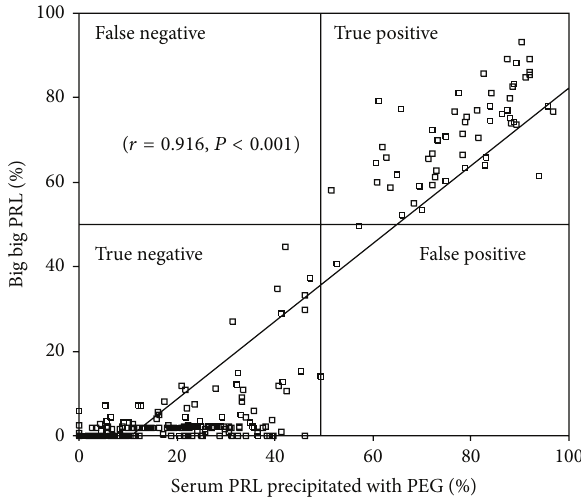
Figure 3: Relationship between the percentages of big big PRL (as determined by gel filtration chromatography) present in serum samples from 326 hyperprolactinemic patients (269 without macro- prolactinemia and 57 with macroprolactinemia) and percentages of serumPRLprecipitatedbyPEG.Thehorizontallinedenotesthe50% limit for percentage of macroprolactinemia, and the vertical line is set to 49.2% of serum PRL precipitated by PEG (see Section